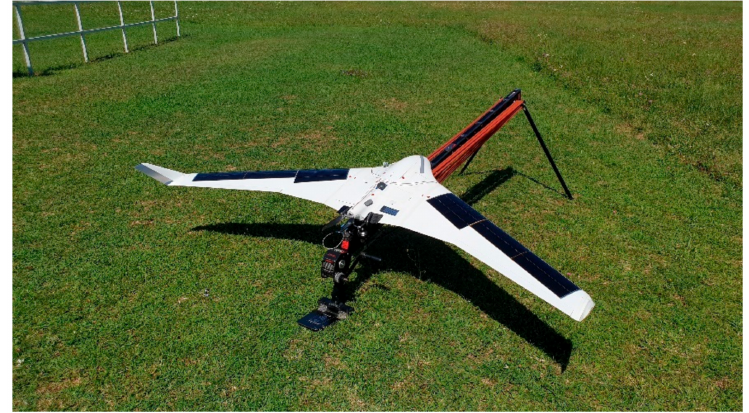
Figure 9. Bramor ppX UAV with solar modules mounted on the wings.